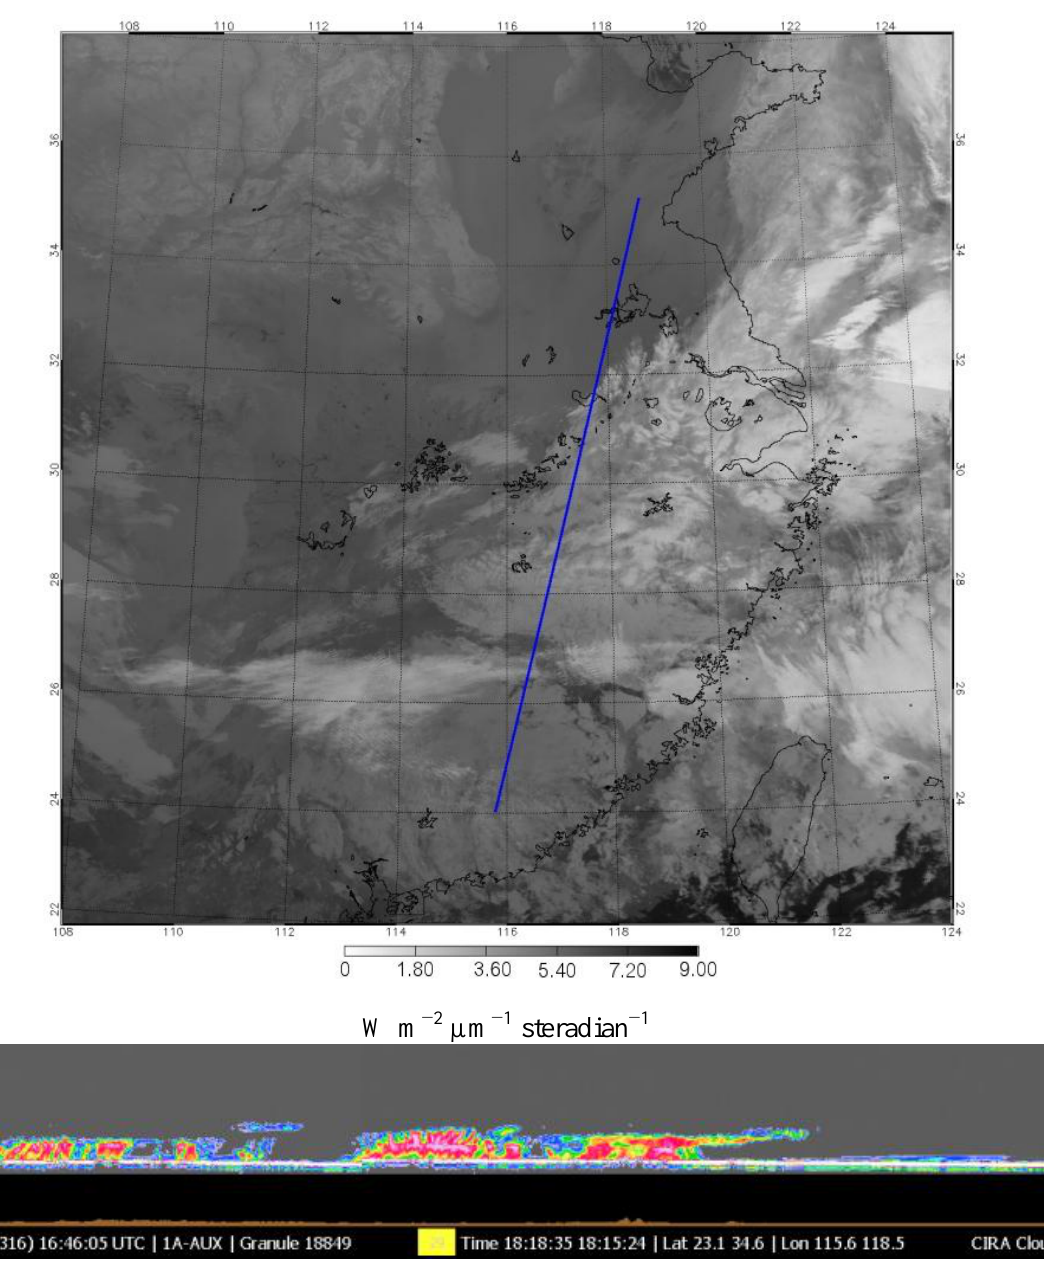
Figure 6. 12 November 2009 1800 UTC. Early season heavy snow storm classified as one of the worst snow storms in decades to hit northern China with over 32 casualties, thousands of acres of crops destroyed, and 15000 buildings collapsed. The CloudSat flight path is shown by the blue line on the IR emissivity image (top). The sensitivity of the CloudSat CPR (bottom) can be used to estimate the vertical and horizontal snowfall distributions from the shallow snow-bearing clouds. Note that the CPR image is a qualitative display of the radar reflectivity (dBZ) increasing from a minimum/blue to a maximum/white. [Courtesy of the Department of Atmospheric Sciences, Colorado State University and the CloudSat project,